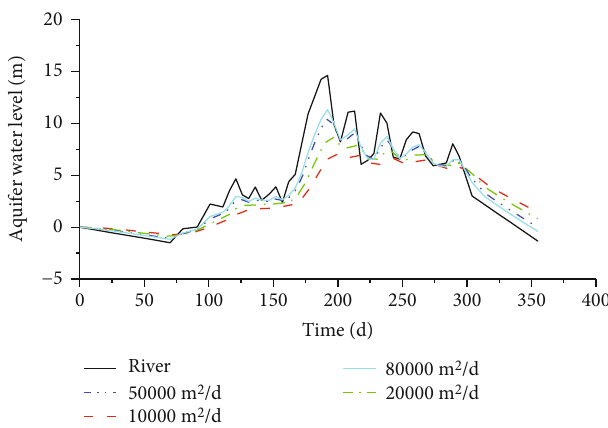
Figure 4: Hydraulic response duration curve in a con fi ned aquifer for di ff erent hydraulic di ff